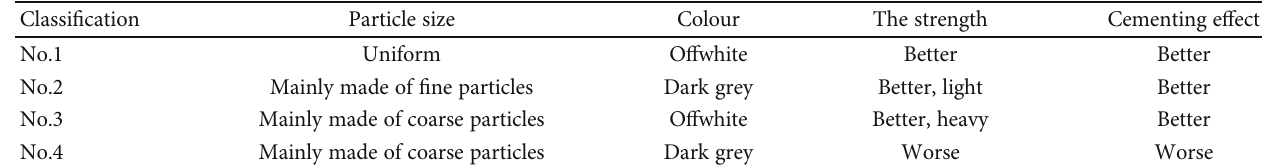
Table 2: Description of back fi ll.